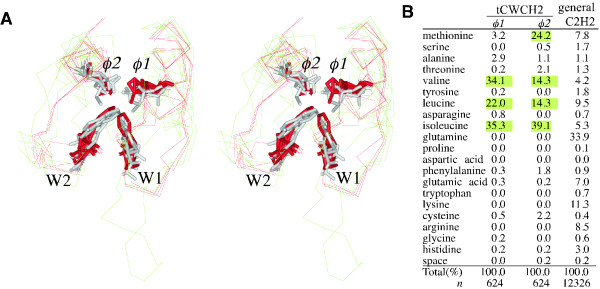
ϕ1 and ϕ2 positions of tCWCH2. (A) Stereo view of the tCWCH2 sequence motif. A wire model of the main chains is shown with ZIC3, GLI1, and Zap1 in green and TFIIIA and Zif268 in red. The side chains of tryptophan residues in tCWCH2 and those in the ϕ1, ϕ2 residues are indicated by cylinders. ZIC3, GLI1, and Zap1 are gray cylinders and the others are red cylinders. The corresponding positions (ϕ1, ϕ2) are indicated by red boxes in Figure 5. (B) Frequency of amino acid appearance in ϕ1, ϕ2, and those of general C2H2 (PDOC00028) is shown. Valine, leucine, and isoleucine appear frequently at both positions and methionine frequently appears in ϕ2. This table summarizes all of the tCWCH2 sequences. Highlighted numbers indicate the preferential residues for ϕ1 and ϕ2 in tCWCH2.